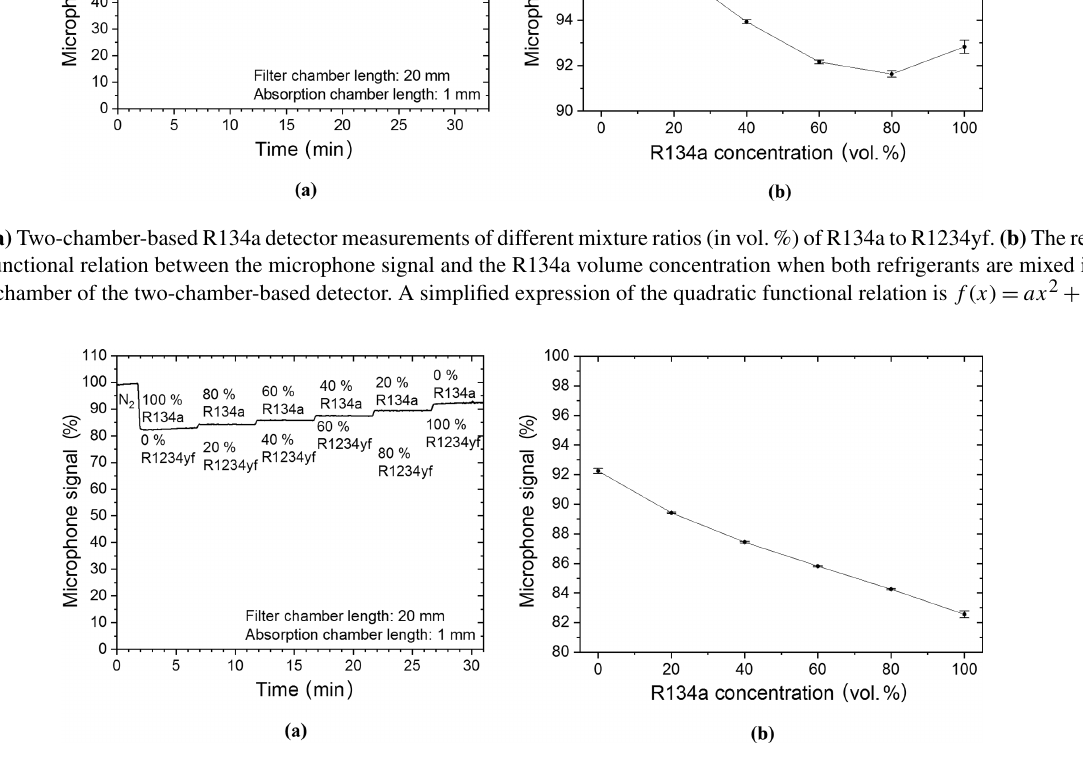
Figure 10. (a) Three-chamber-based R134a detector measurements of different mixture ratios (in vol.%) of R134a to R1234yf. (b) The resulting exponentially decaying relation between the microphone signal and the R134a volume concentration after reducing the cross